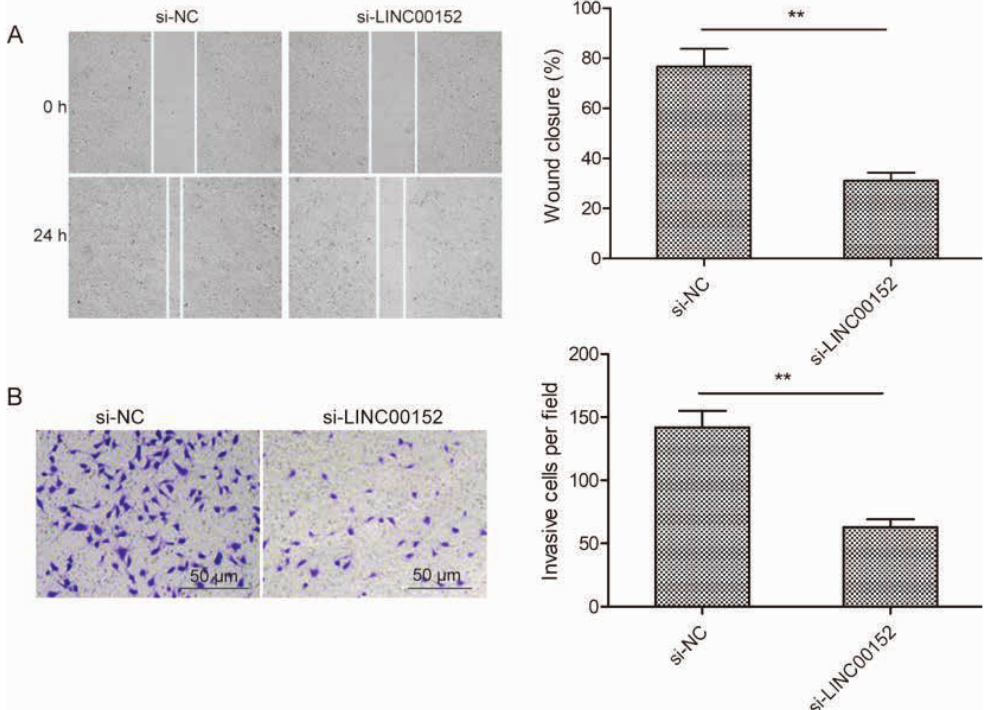
Figure 3: LINC00152 depletion inhibits invasion and migration of LSCC cells. (A) The migration ability was examined in TU212 cells transfec- ted with si-LINC00152 or si-NC by wound healing assay.(B) The invasion ability was examined in TU212 cells transfected with si-LINC00152 or si-NC by Transwell invasion assay. **P <